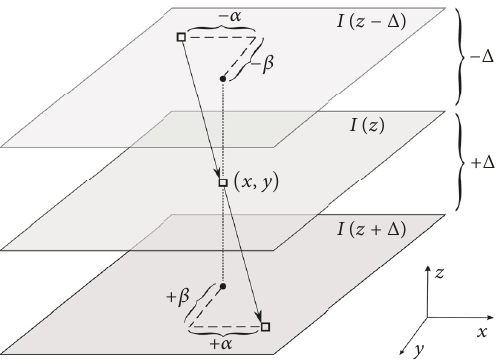
Figure 2: Illustration of the symmetric interpolation